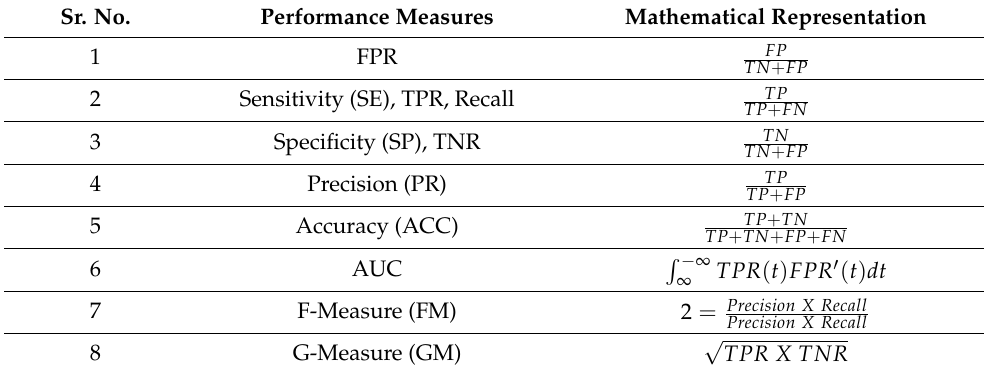
Table 4. Performance evaluation metrics.